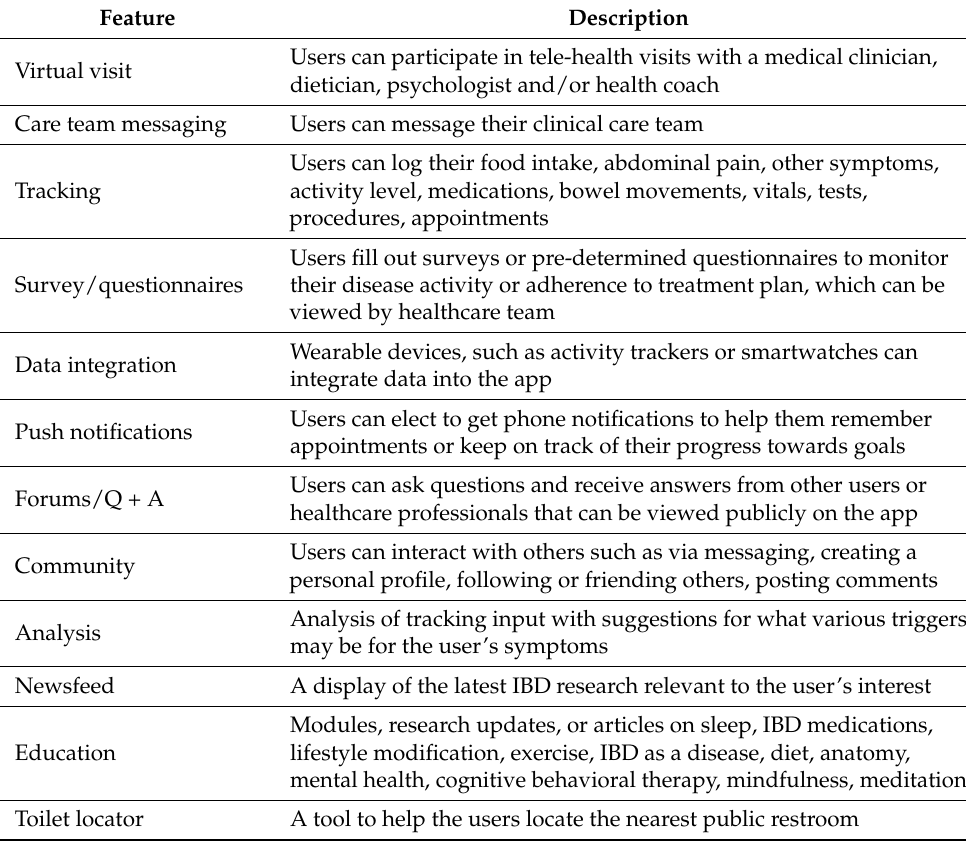
Table 2. Common Features of IBD Mobile Applications.